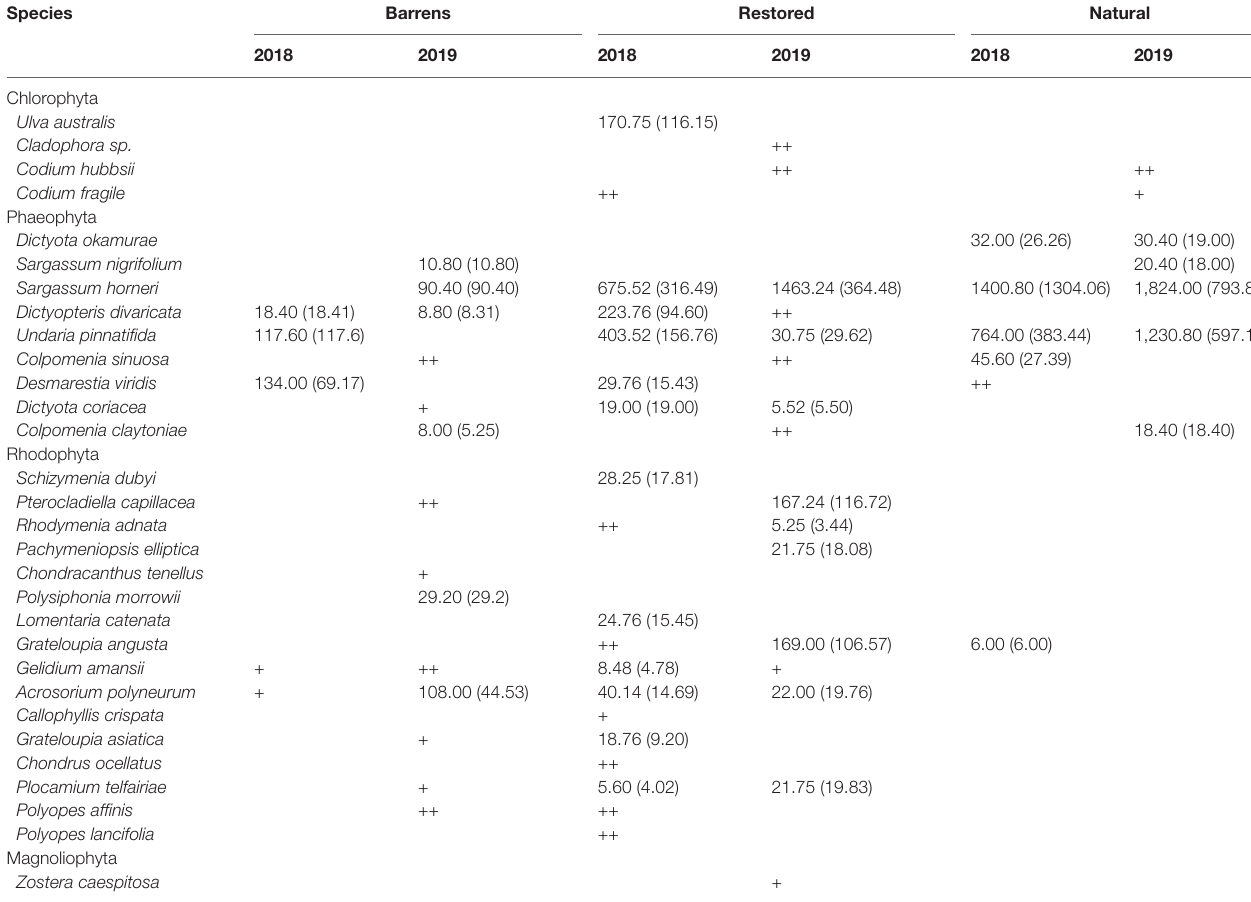
TABLE 1 | Spatial and temporal changes of biomass (g wet weight m -2 ) of macroalgae in barrens, restored bed, and natural bed.